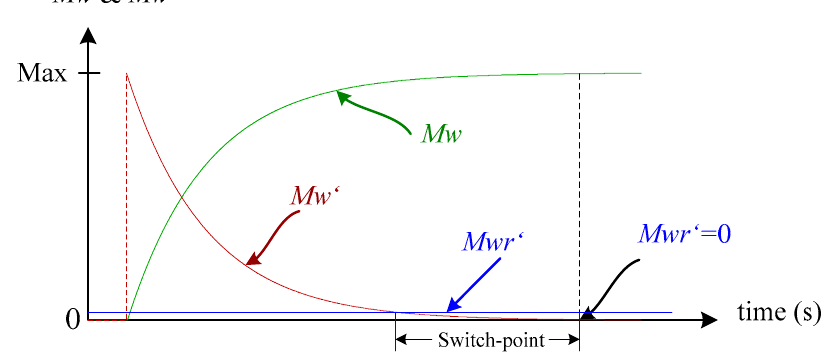
Figure 7. Milk weight and its derivative with respect to time.